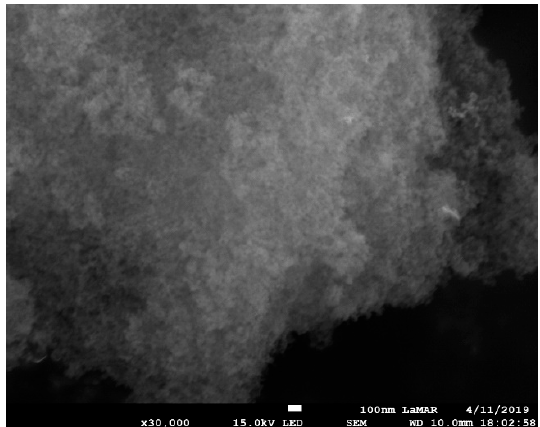
Figure 6. SEM image of SiO 2 -Gd 2 O 3 :Eu 3+ (1%) nanoparticles at 3 × 10 4 times magnification, revealing aggregates with homogeneous distribution. The mean size of the silica nanoparticles is much smaller than that of the silica-free nanoparticles. The scale bar corresponds to 100 nm. The elements in SiO 2 -Gd 2 O 3 :Eu 3+ (1%) nanoparticles were also mapped by X-ray